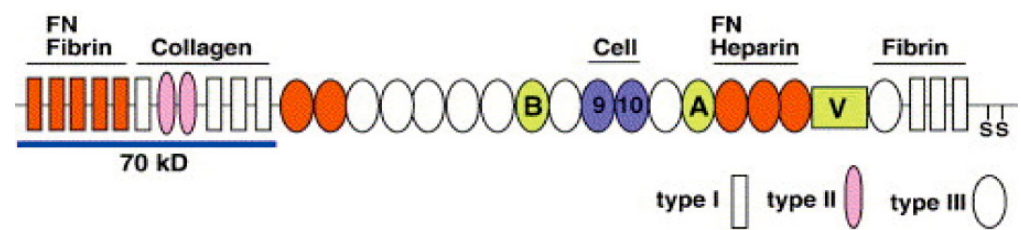
Figure 4. Schematic view of the structure of fibronectin. Binding sites for other proteins and three repeat modules are indicated. Reprinted from Ref. [48]. Copyright (2005) Elsevier.